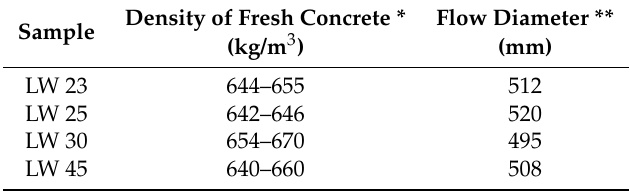
Table 5. Fresh properties of the